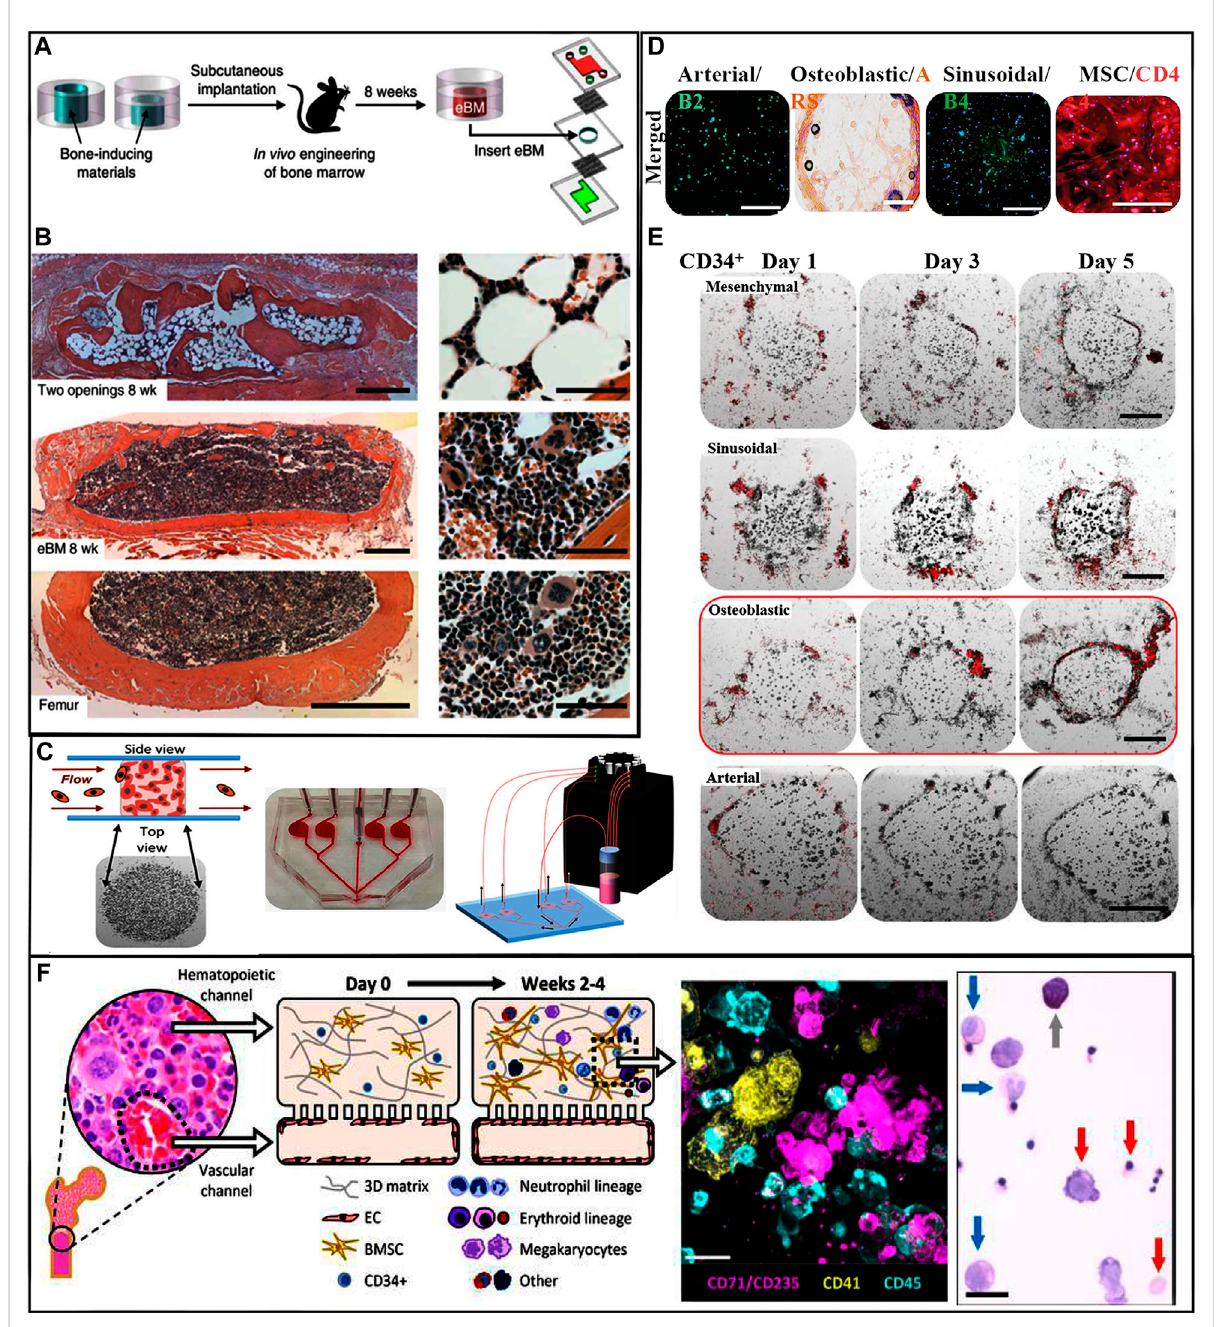
FIGURE 4 (A) Schematicofwork fl owtofabricateBMon-a-chip,inwhicheBMisformedinmouseandisthenculturedinamicro fl uidicsystem. (B) Images show the establishment of eBM with in vivo-like histological BM structure. (Top) Hematoxylin-and-eosin-stained sections of the post-implanted eBM formed in the PDMS device with two opening. (Center) Histological sections of the post-implanted eBM formed in the PDMS device with one lower opening. (Bottom) Cross-section of BM in a normal adult mouse femur. Scale bars: 500 and 50 µm for low and high magni fi cation views, respectively. (Torisawa et al., 2014) Figure 4A, B: Copyright © 2014. Reproduced with permission from Springer Nature. (C) Niche-on-chip micro fl uidic chip. (Left) Side and top view depictions of the niche constructs in the device chambers. (Center) Schematic of multi-niche-on-chip device. (Right) Schematic of operational recirculating multi-niche-on-a-chip systems. (D) Live/dead viability staining of each niche construct type. Scalebars:100µm. (E) Fluorescentimagesofniche-on-a-chiplodging/retentionexperimentsusingCD34+HSCs.Scalebar:250µm.(Alemanetal., 2019) Figure 4C-E: Copyright © 2019. Reproduced with permission from John Wiley and Sons. (F) Schematic illustration of the vascularized BM on- a-chipwithCD34+progenitorsandMSCsinthetopgelchannelandavascularlininginthebottomchannel.Immuno fl uorescenceimageofavertical cross-section through the upper channel of the BM chip. Scale bar: 20 µm. Wright-Giemsa staining image of cells from the BM chip showing multilineage differentiation. Scale bar: 20 µm. (Chou et al., 2020). Copyright © 2020. Reproduced with permission from Springer